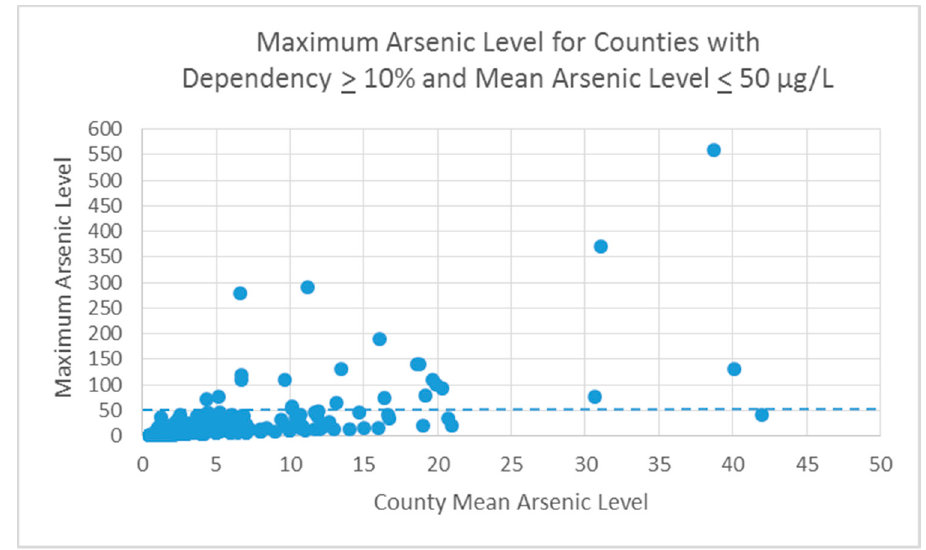
Figure A1. County drinking water maximum arsenic level by county drinking water mean arsenic level for counties with dependency ≥ 10% and mean drinking water arsenic level <50 μ g/L. Table A1. Adjusted Poisson log-linear model with ln mean arsenic, >10% dependency, and ND = 1/(sqrt 2) × LOD [Mendez model].